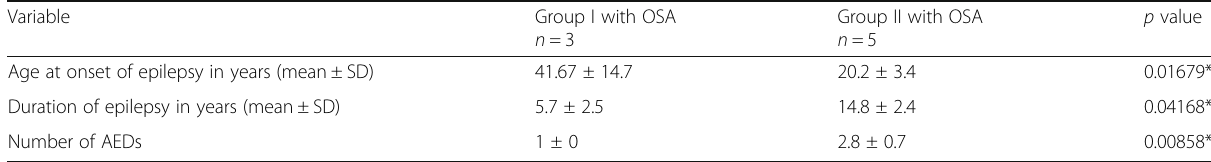
Table 4 Comparison between epilepsy related clinical data among patients with OSA in both groups Variable